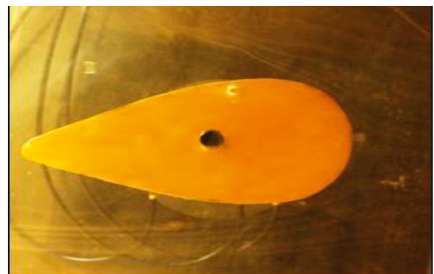
Figure 27: Smoke flow visualization at 10 ° AOA for the 1st module open.